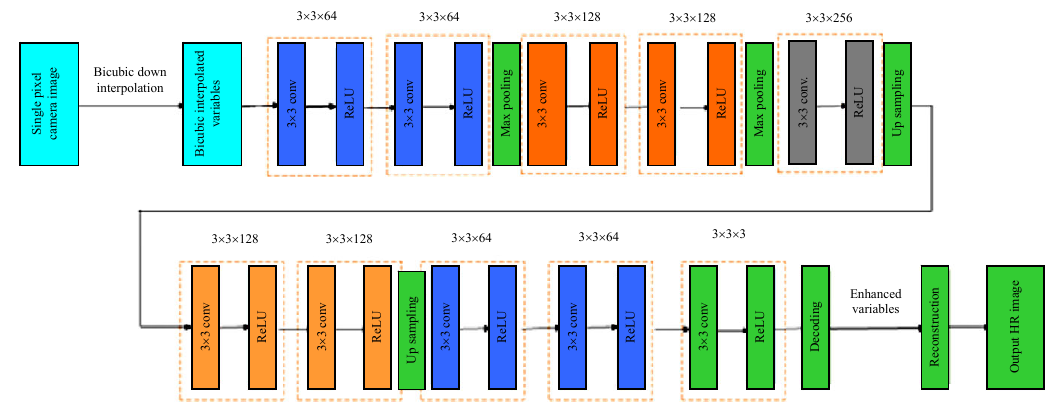
Fig. 6 Framework of proposed CS-SRCNN